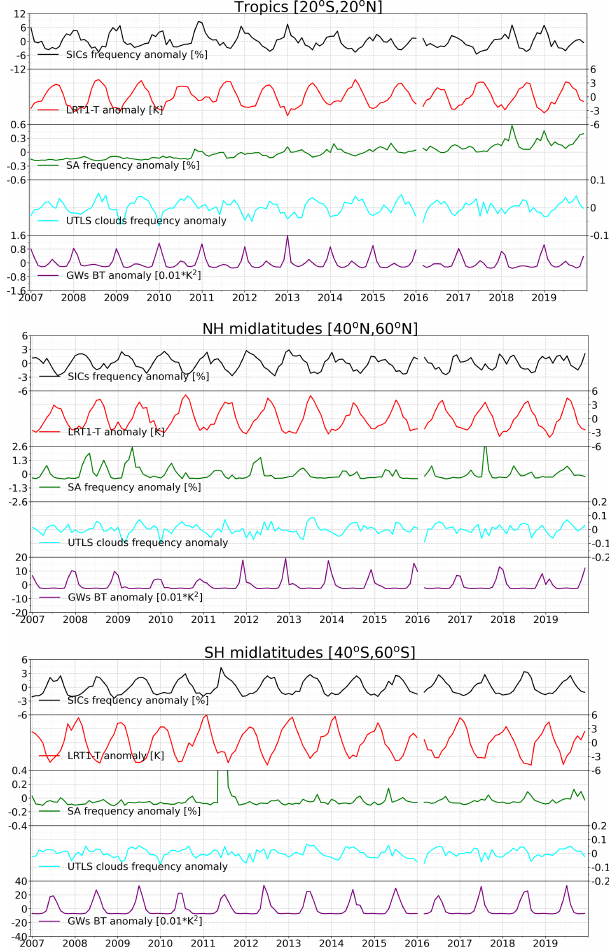
Figure D1. Regional averaged monthly anomalies of SIC occur- rence frequency, LRT1 temperature, stratospheric aerosol occur- rence frequency, UTLS clouds, and gravity waves from 2007 to 2019 over the tropics (20 ◦ S–20 ◦ N), northern midlatitudes (40– 60 ◦ N), and southern midlatitudes (40–60 ◦